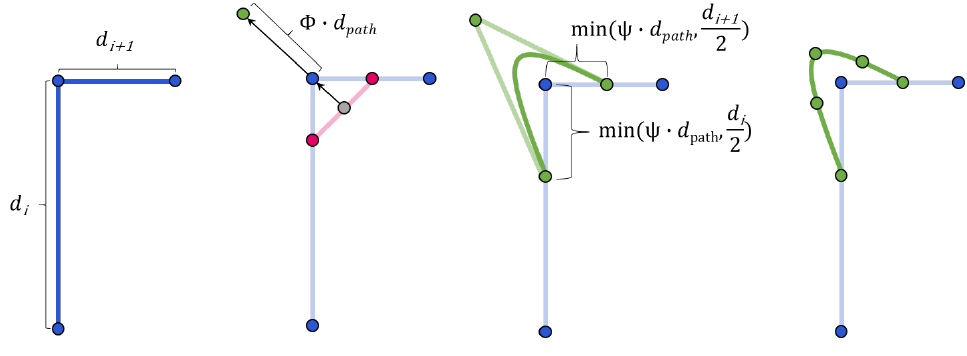
Figure 17. Smoothing algorithm steps. Table 3. k ω , i values for the quasi unsmoothed path and the smoothing limit cases.